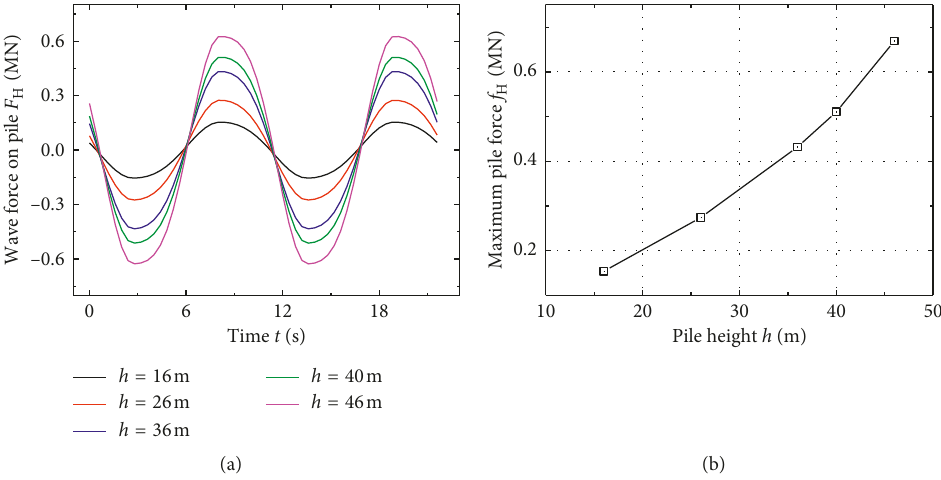
Figure 5: Total wave force on a pile with different lengths. (a) Time series. (b) Maximum values.